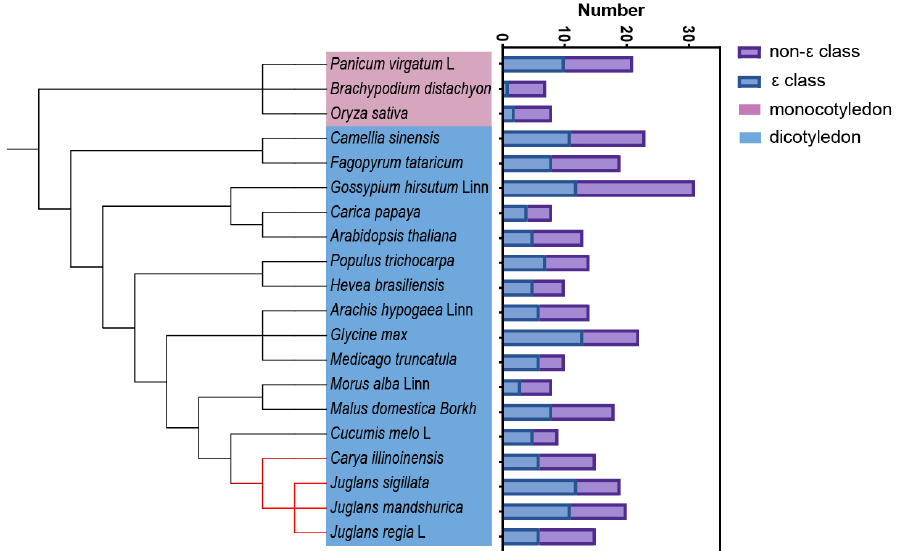
Figure 10. Comparison of the number of GRF genes in 20 crops.